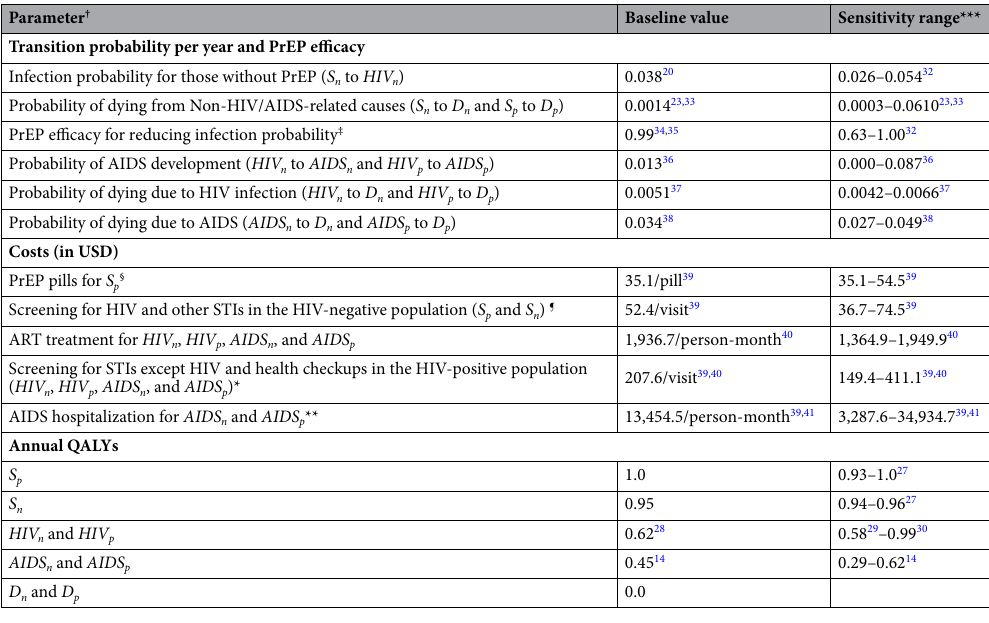
Table 1. Parameter values for the Markov model and cost-effectiveness analysis. PrEP, pre-exposure prophylaxis. † Transition probabilities are per year and costs are per month. ‡ The transition probability ( S p to HIV p ) is the product of the transition probability ( S n to HIV n ) and 1-(PrEP efficacy). § Cost of PrEP pills per month calculated as a product of PrEP pill cost (per pill) and the number of pills per month (30